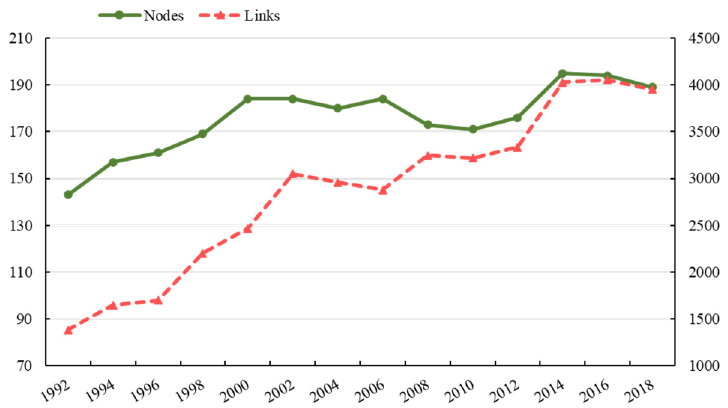
Figure 1. The evolution of the scale of the global FTN.